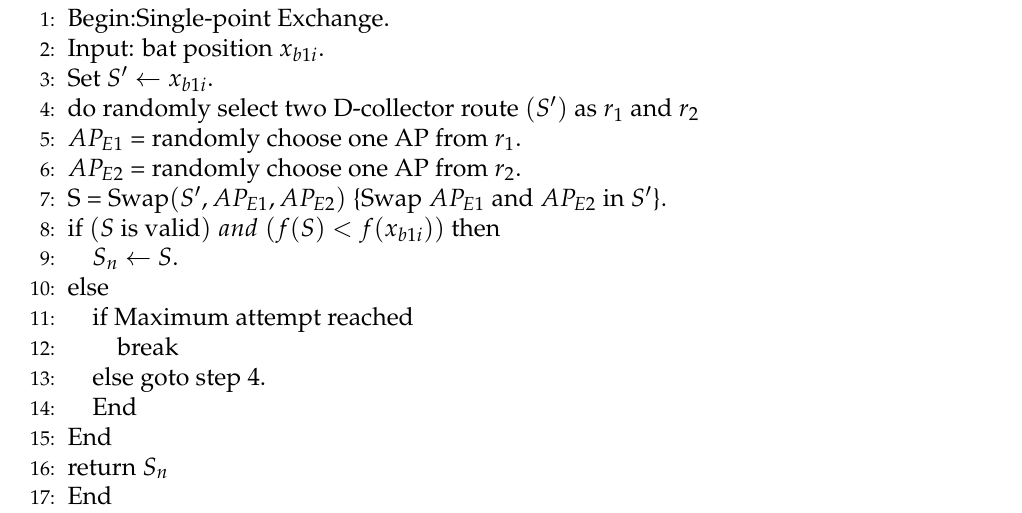
Algorithm 5 Single point exchange algorithm.